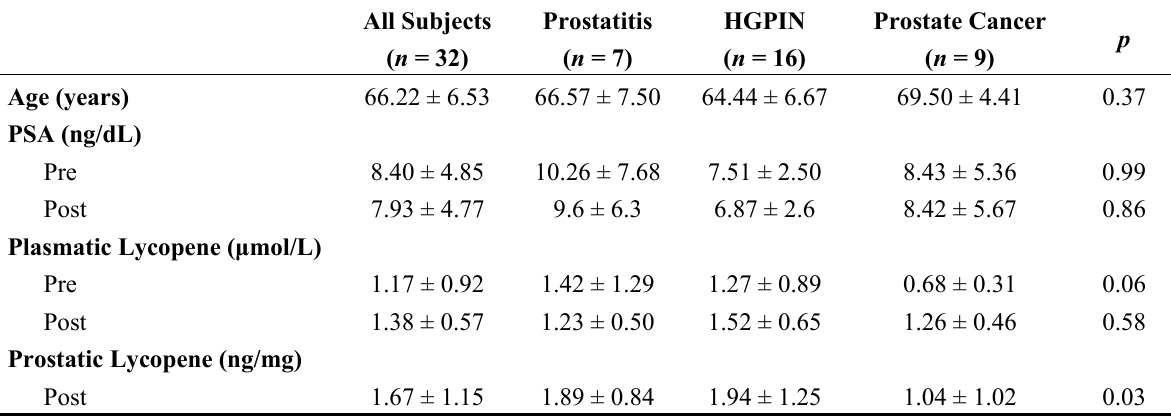
Table 1. Group differences in age, PSA, plasmatic and prostatic lycopene concentrations before and after lycopene